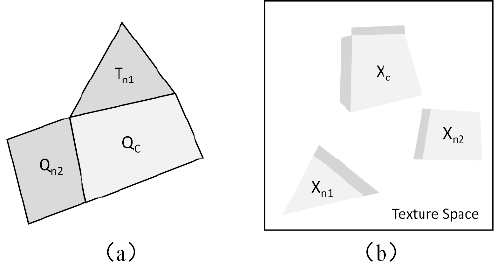
Figure 11. Texture extension (CV = 1): ( a ) Qc is a polygon waiting to be synthesized and has one synthesized neighbor (Qn). Qc is rotated around the shared edge (P1 P2) to place it on the same plane as Qn. ( b ) In the space of the texture sample, wi is the mapped point of Pi and (si, ti) is the corresponding texture coordinate of Pi. The texture coordinates of P3 and P4 can be deduced from the known texture coordinates of P1 and P2 based on the geometric relationship between the rotated Qc and Qn. ISPRS Int. J. Geo-Inf. 2017 , 9 , x FOR PEER REVIEW